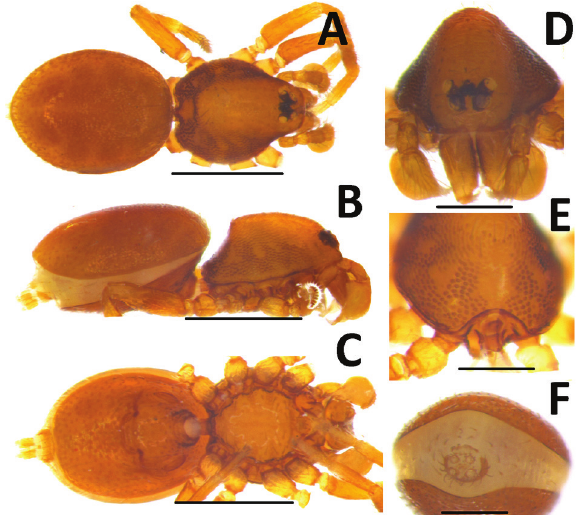
Figure 18. Silhouettella tiggy n. sp., male from Corbett’s Gap: A , habitus, dorsal view; B , same, lateral view; C , same, ventral view; D , carapace, anterior view; E , same, posterior view; F , ab- domen, posterior view. Scale bars: 0.5 mm ( A–C ), 0.2 mm ( D–F ).